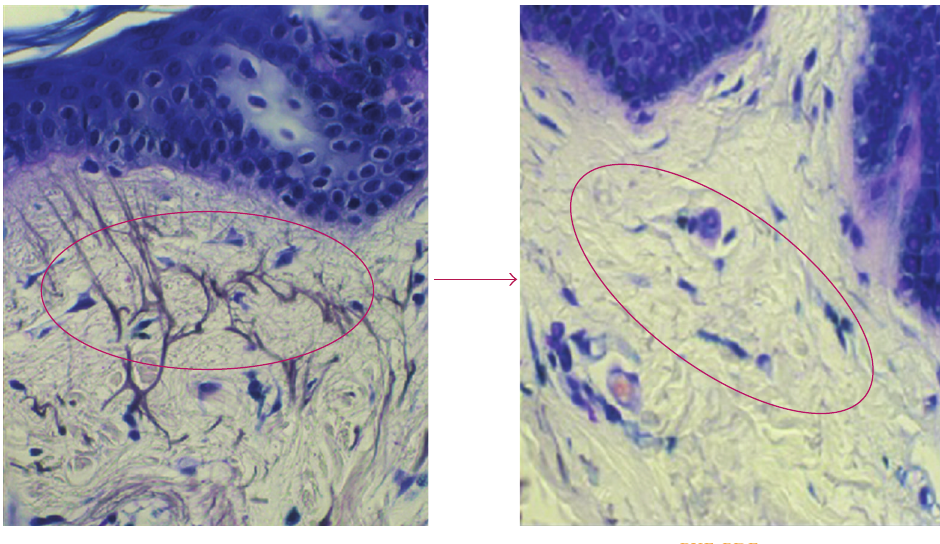
Figure 3: Presence of the elastic fibers in a perpendicular orientation on the dermis papillary (Normal) versus the absence of elastic fibers, presented in the